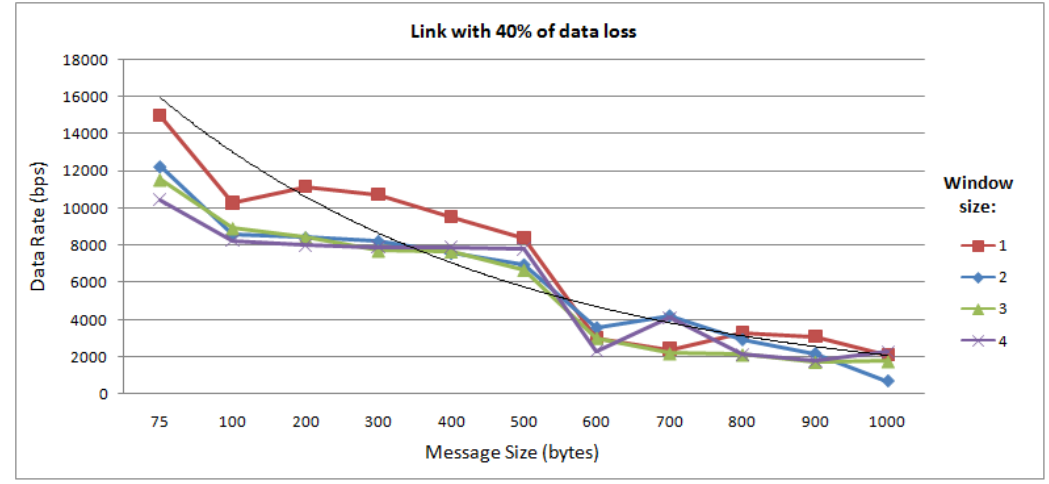
Figure 10. Data rate in the communication between the Sink and MDC, in a link with 40% loss